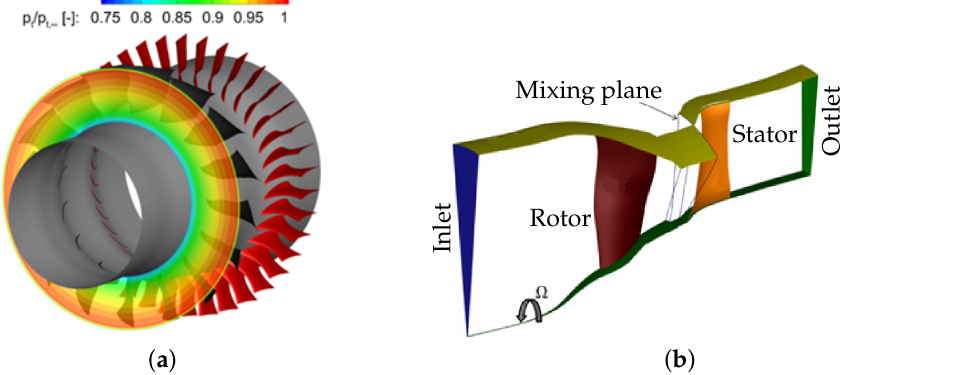
Figure 7. Illustration of investigated Aft-Propulsor and CFD domain. ( a ) Exemplary shape of the inflow distortion of Aft-Propulsor configuration. Source: [31], reproduced with permission. ( b ) Exemplary illustration of single-passage computation domain for CFD. Source: [12], reproduced with